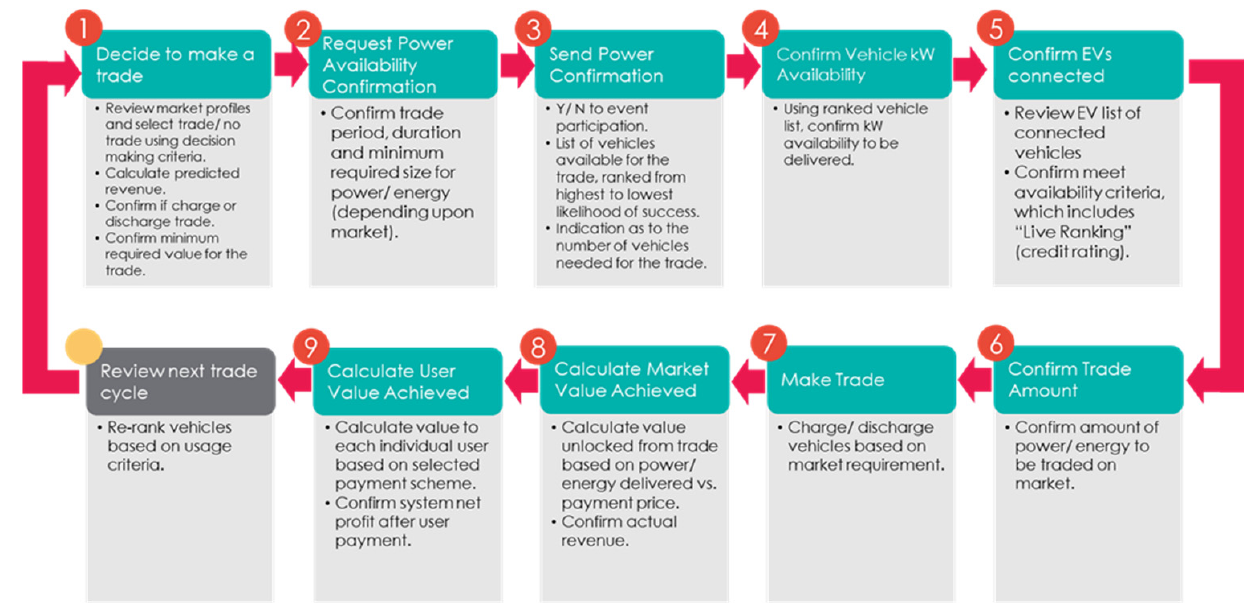
Figure 2. Schematic of the process of making energy trades using the Live Service.